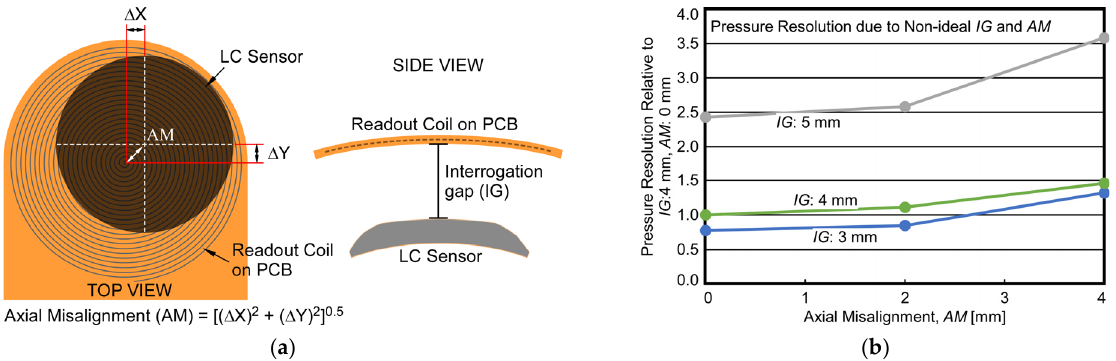
Figure 12. ( a ) Illustration of axial misalignment ( AM ) and interrogation gap ( IG ). ( b ) Measured pressure resolution with non-ideal AM and IG .